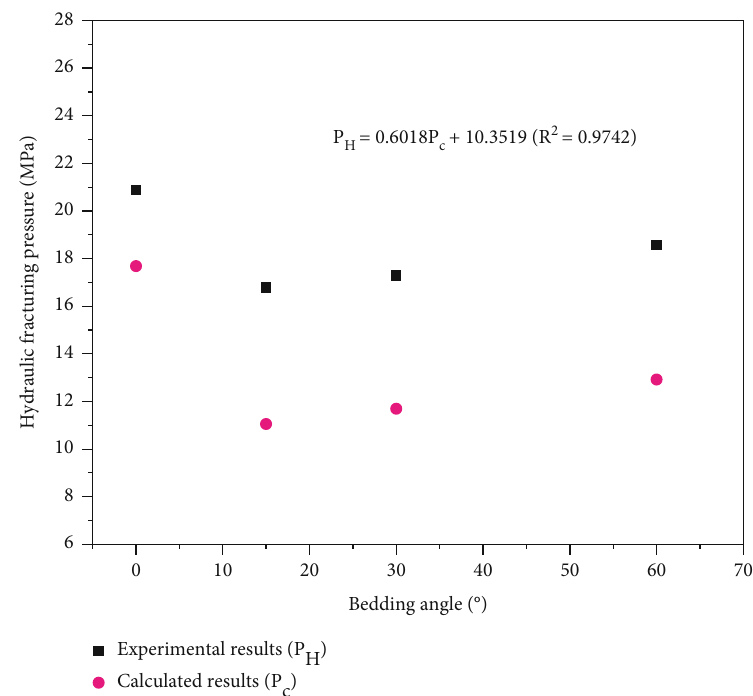
Figure 11: Correlation between theoretical calculations and experimental